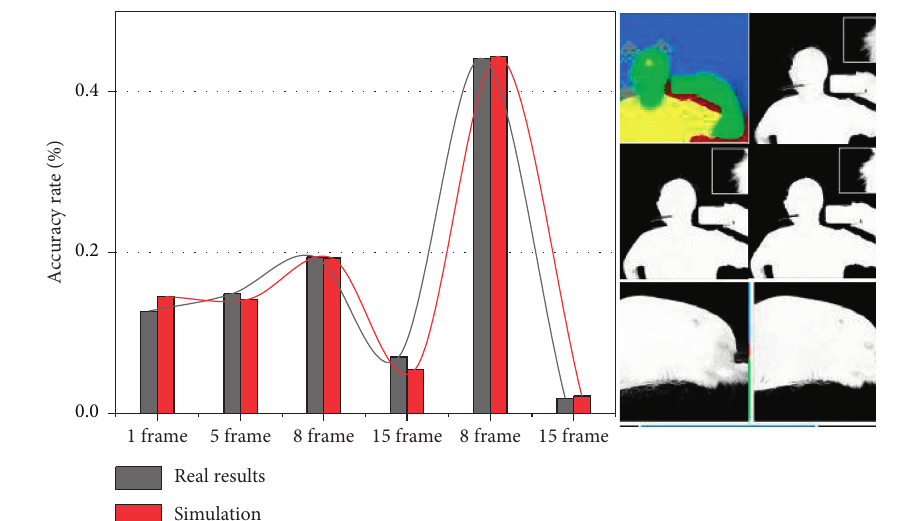
Figure 5: Optical flow diagram corresponding to two consecutive RGB